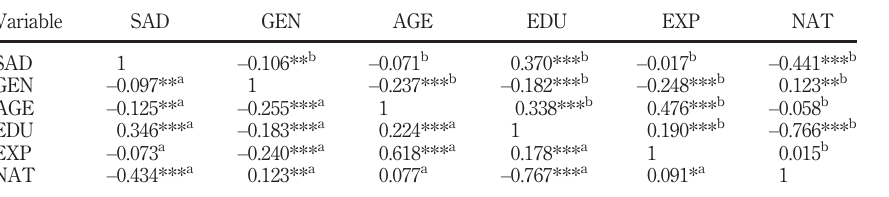
spearman correlation